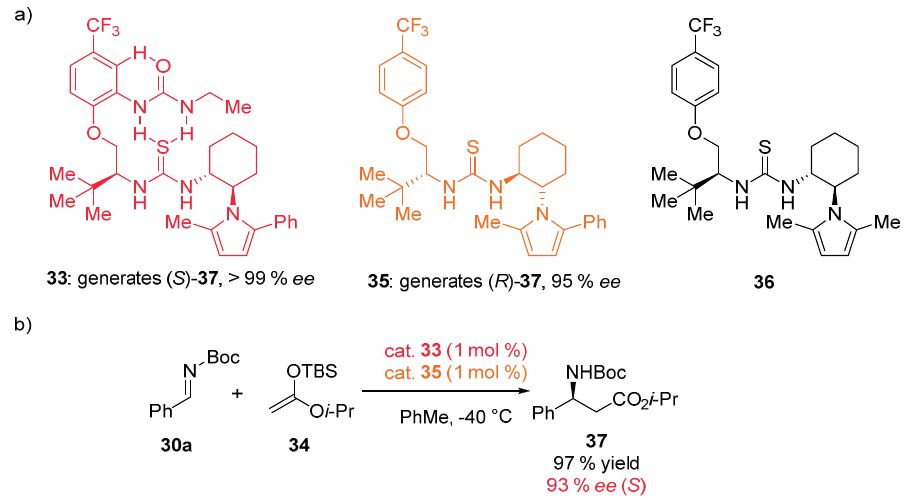
Figure 9. Structures of the catalysts used in the study ( a ); Mannich reaction kinetic experiment demonstrating higher activity of catalyst 33 ( b